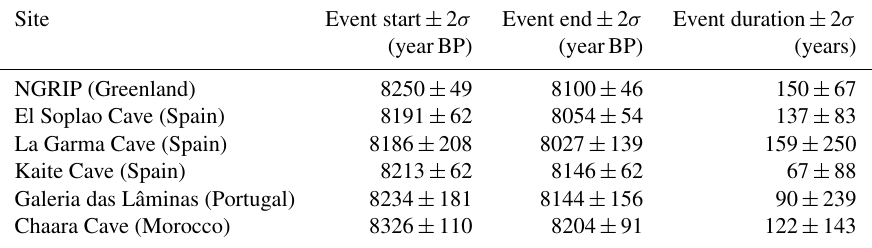
Table 2. The timing of the 8.2ka event from the selected archives discussed in this paper. See text for explanation for determining the onset and end of the